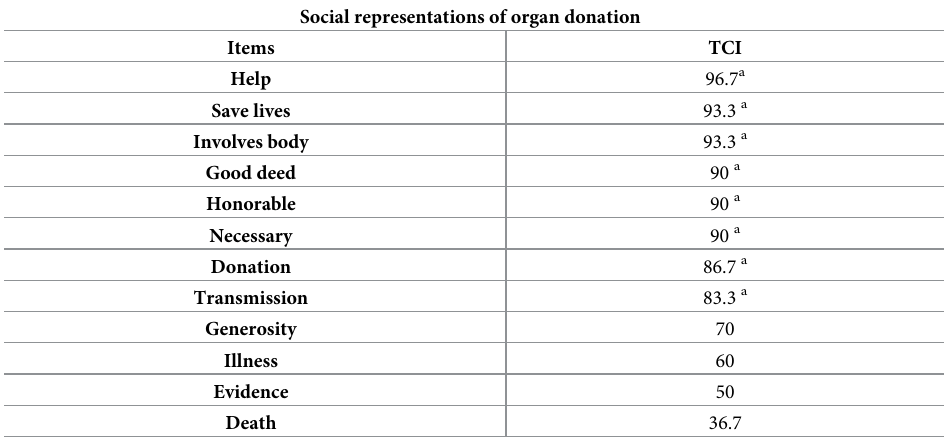
Table 1. Results of the TCI for social representations of organ